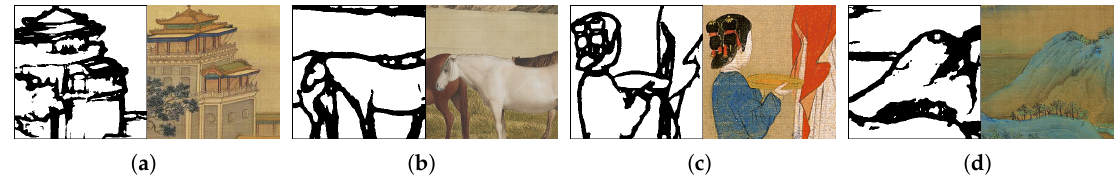
Figure 3. Exemplary pairs from our training data, sketches (left) and paintings (right). ( a ) Along the River during the Qingming Festival; ( b ) One Hundred Horses; ( c ) Spring Morning in the Han Palace; ( d ) A Thousand Li of Rivers and